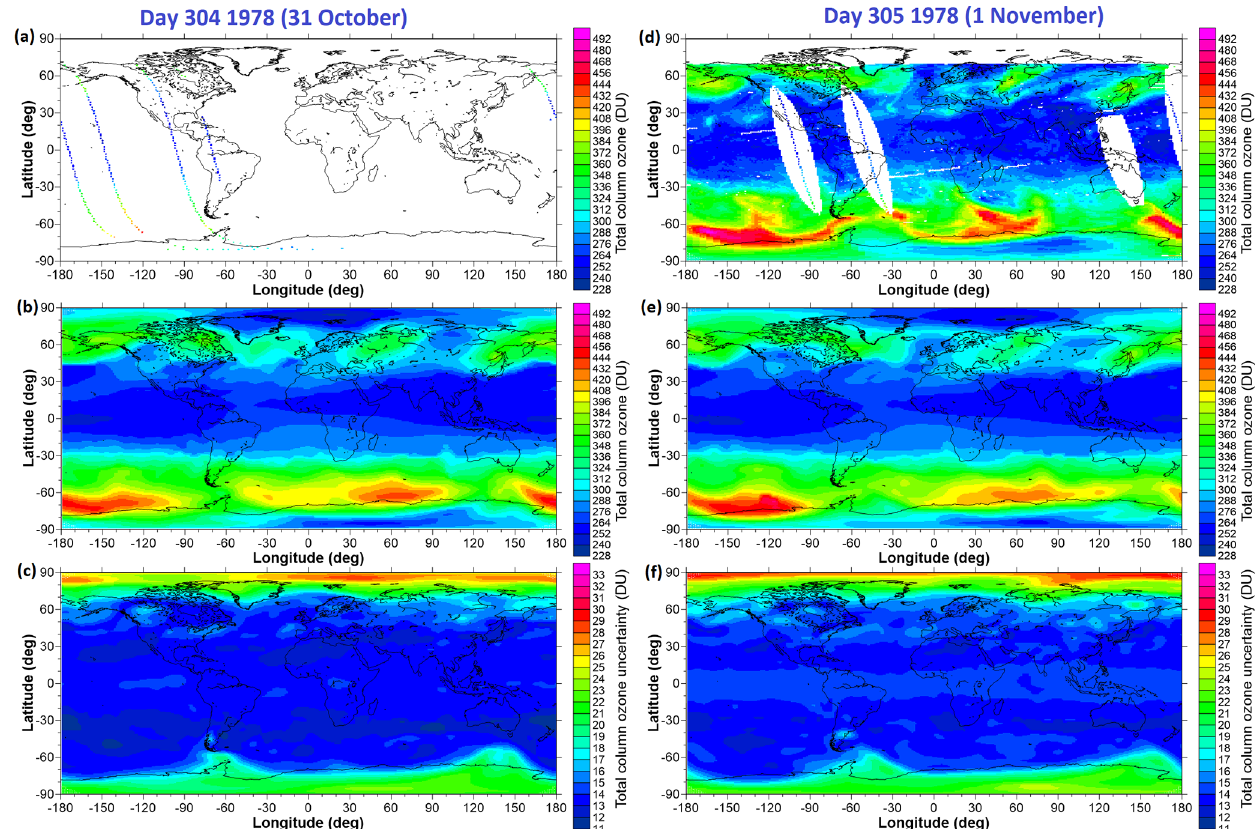
Figure 14. (a, d) The original unfilled TCO fields on 31 October and 1 November 1978, respectively; (b, e) the machine-learning-modelled fields; (c, f) the uncertainties associated with the machine-learning-modelled fields. On 31 October, the optimal fit was obtained by expanding the offset basis function in spherical harmonics of degree 10 and order 5, expanding the tropopause height basis function in spherical harmonics of degree 4 and order 3, and the PV at 550K basis function in spherical harmonics of degree 5 and order 3. For 1 November, these expansions were (10 , 5) for the offset basis function (4 , 3) for the TH basis function and (5 , 4) for the PV550K basis